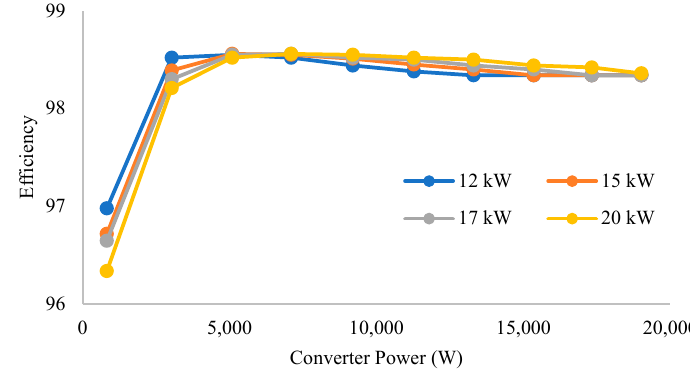
Figure 7. Efficiency curves for four different power levels.